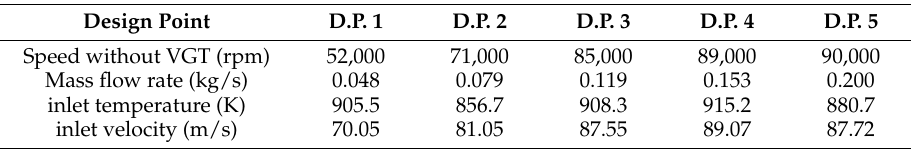
Table 16. Inlet boundary conditions with maximum turbine